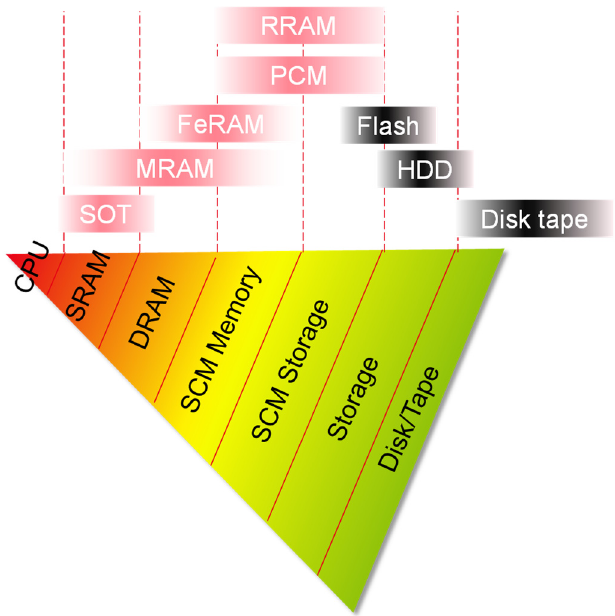
Figure 8. Possible implementation of emerging memories in the memory hierarchy based on the benchmark presented in Figure 6.